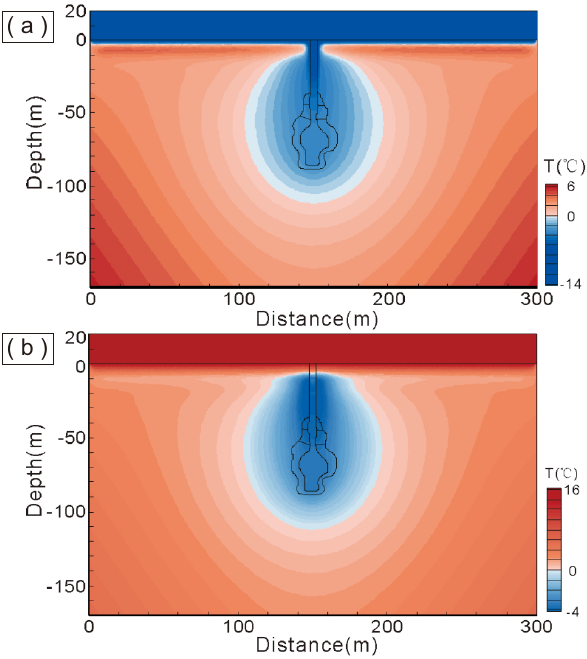
Figure 5. Temperature distribution around Ningwu ice cave in win- ter (a) and summer (b)